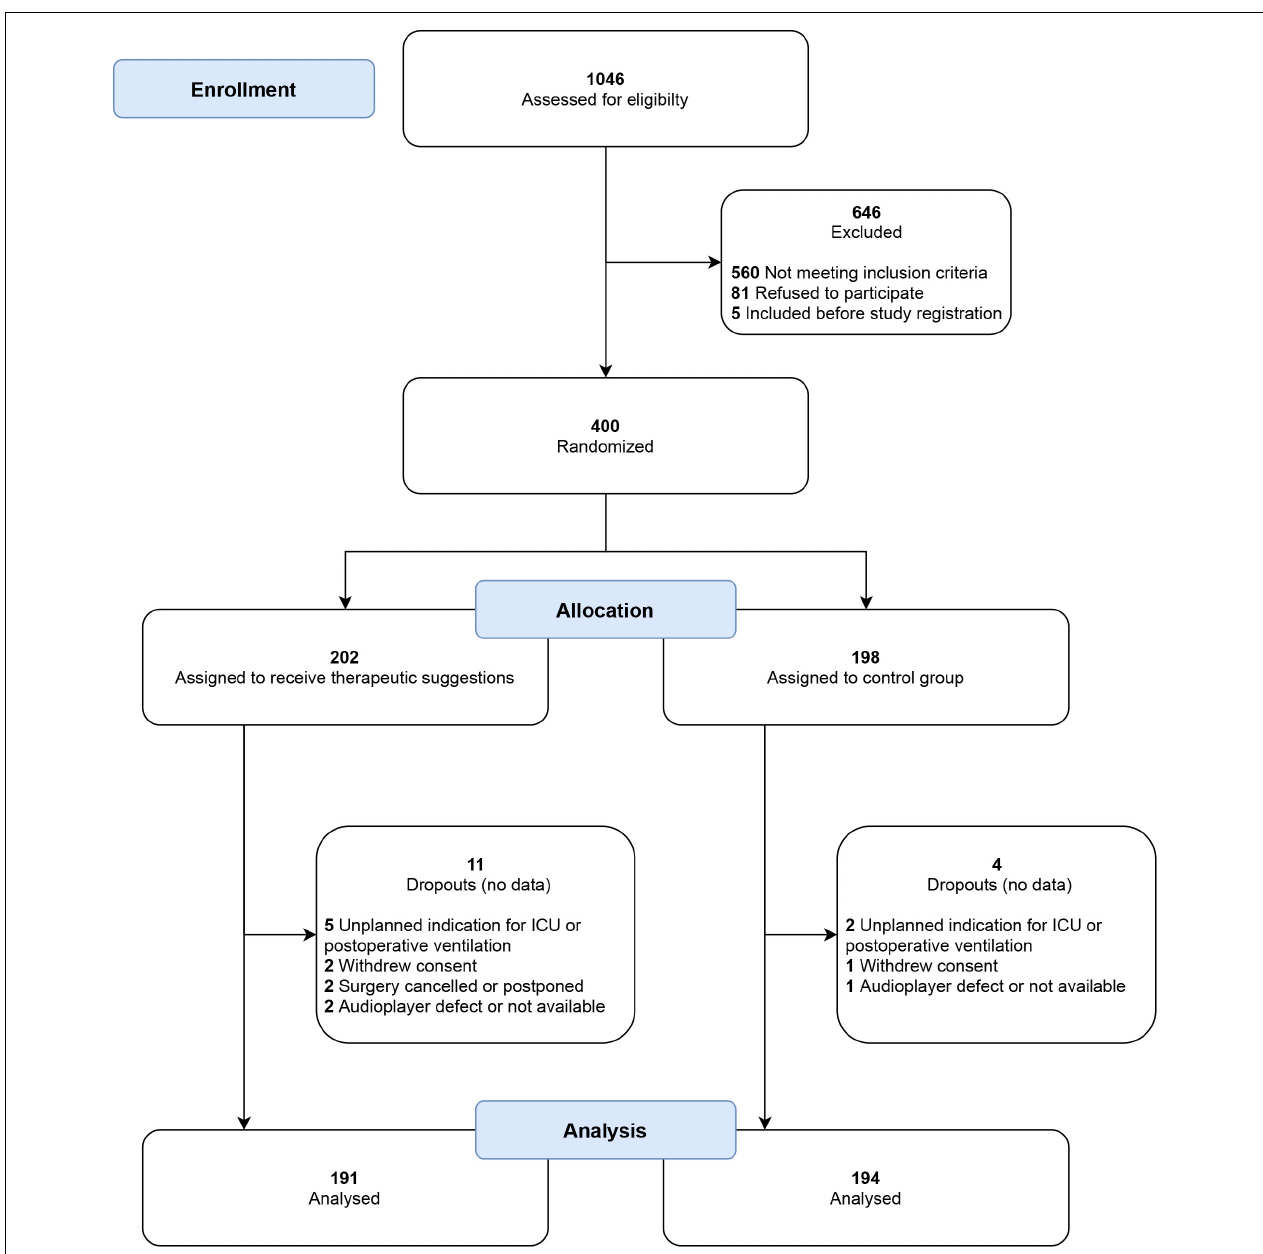
FIGURE 2 | CONSORT flow chart of patient recruitment. No postoperative data were collected for dropouts, and they were excluded from analysis before unblinding of the study. ICU, intensive care